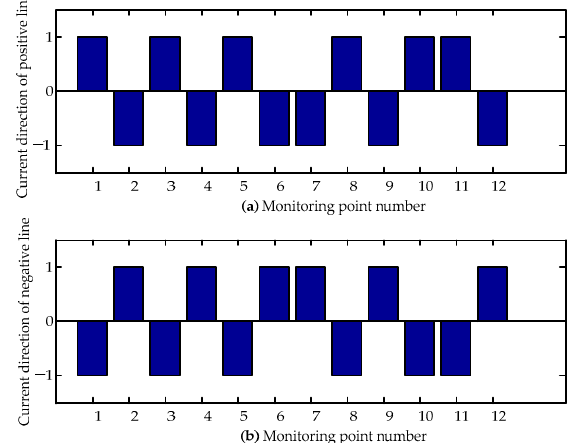
Figure 10. The current flow of monitoring point during normal operation: ( a ) Positive line; ( b ) Negative line.